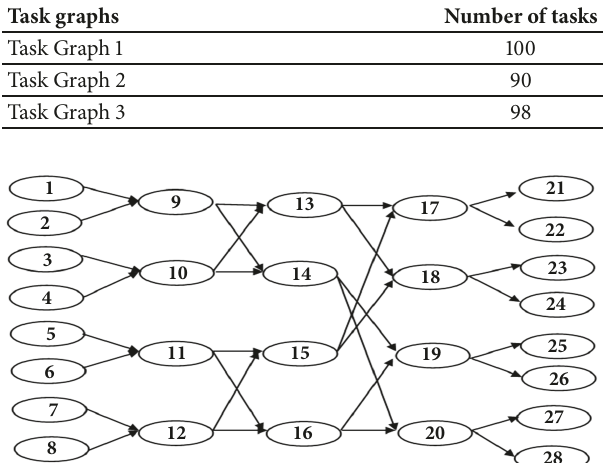
Table 7: Three selected task graphs. Task graphs